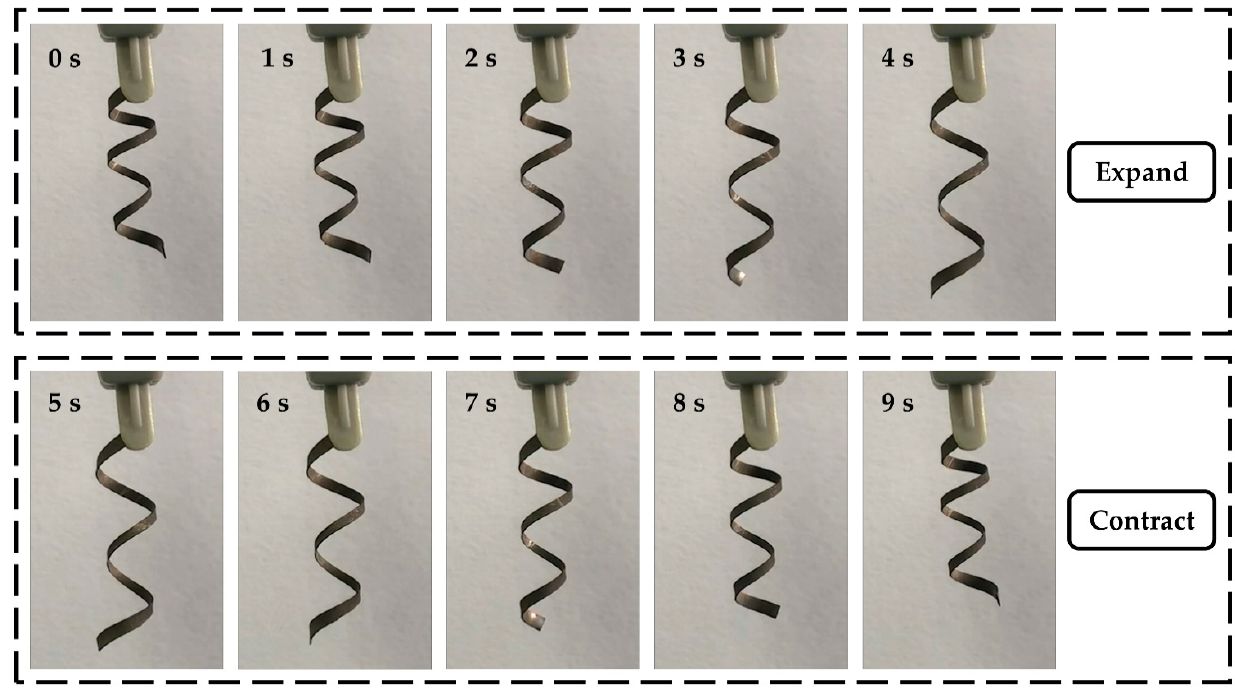
Figure 3. Three-dimensional motion of the helical IPMC actuator in a sinusoidal period.